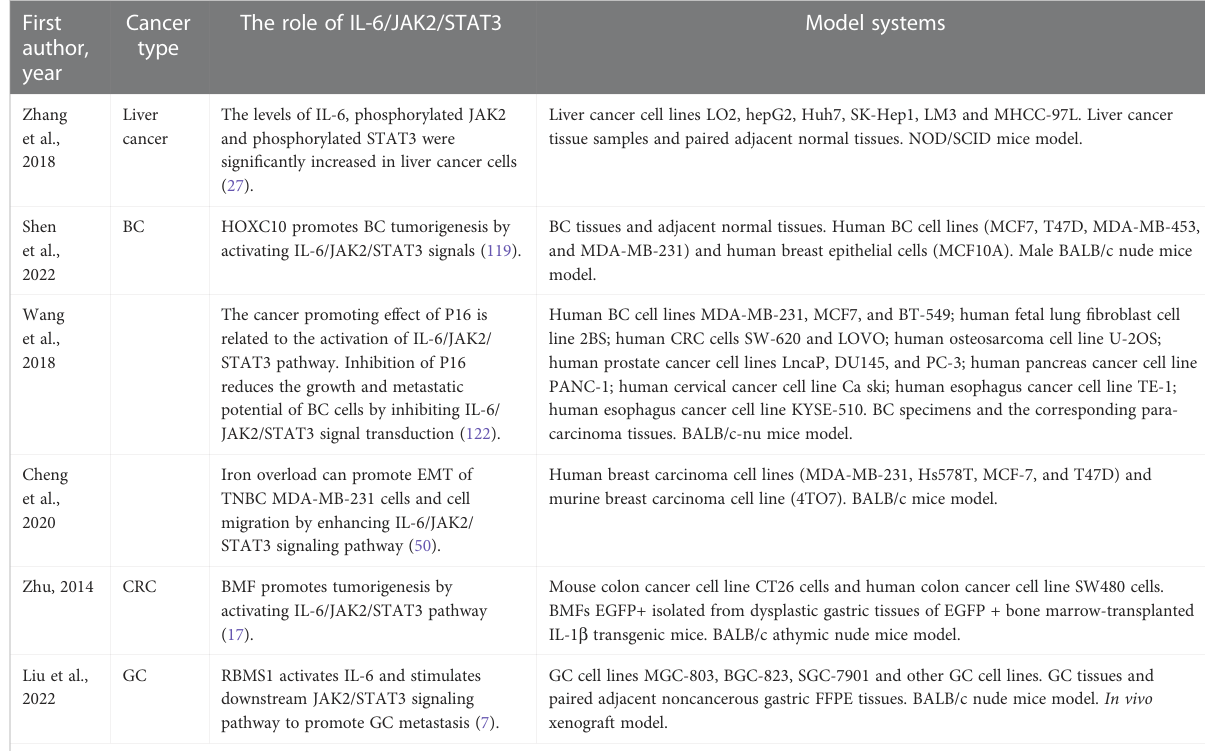
TABLE 1 The role of IL-6/JAK2/STAT3 in cancers.